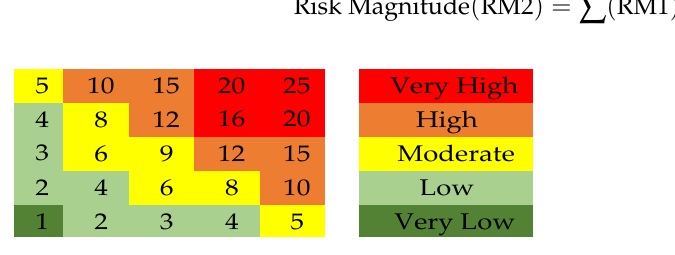
Figure 2. 5 Classes Matrix Matrix.